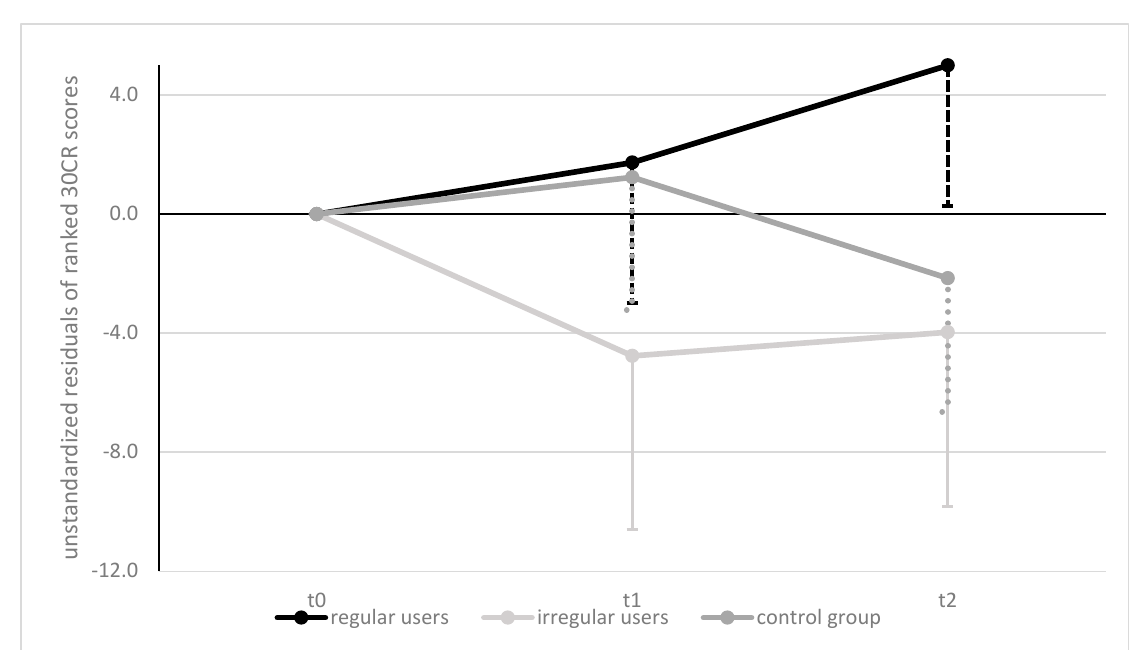
Figure 4. Mean Differences in 30CR ANCOVA Results, Over Time and Between Groups/30CR = 30 Seconds Chair Rise test. Data presented as unstandardized residuals of ranked scores on all three test dates adjusted for baseline scores. Error bars (one-sided): 95% CI.